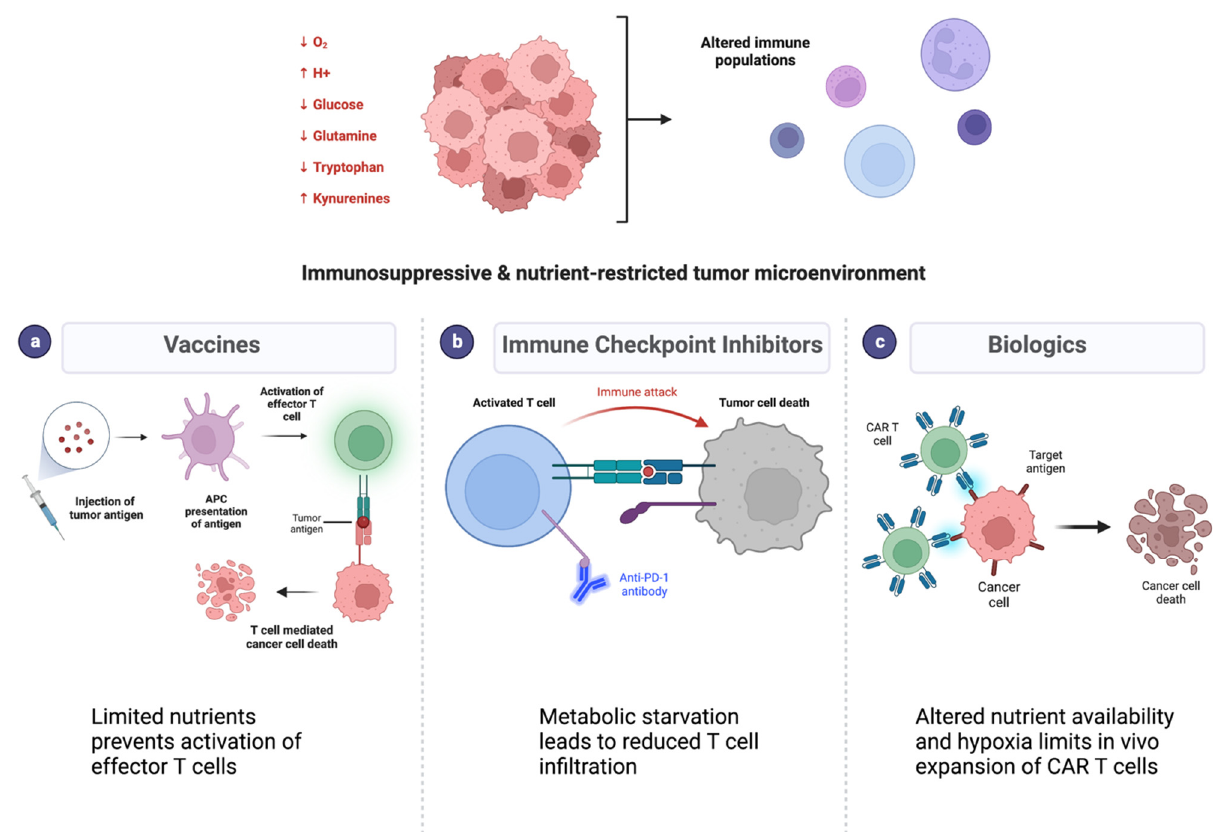
Figure 3. Immunosuppression and nutrient depletion in the tumor microenvironment limit efficacy of immunotherapies in glioblastoma. ( Top ) Cancer cell metabolism alters the pH, oxygen, and metabolite contents in the tumor microenvironment. ( Bottom ) Metabolic alterations result in resistance to different classes of immunotherapies such as vaccines (a), immune checkpoint inhibitors (b), and biologic therapies (c). Each of these mechanisms relies on an effective immune response which is diminished with metabolic alterations.